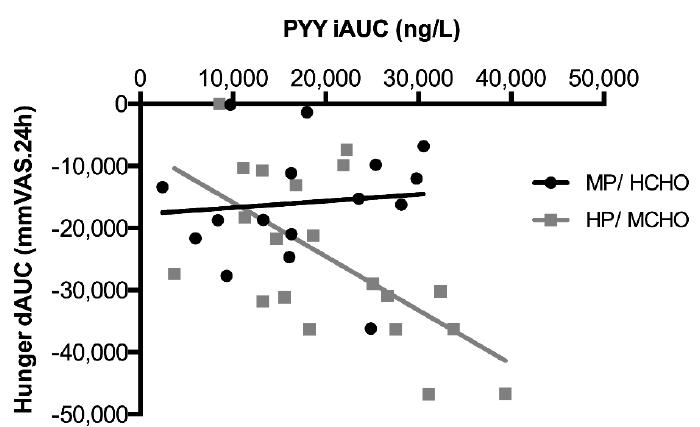
Figure 5. Inverse association of hunger and PYY concentrations throughout the day in the MP/HCHO ( ) and HP/MCHO ( ) group. Regression lines are shown in black (MP/HCHO) and grey (HP/MCHO, r = 0.710, p = 0.001). MP/HCHO = moderate protein/high carbohydrate; HP/MCHO = high protein/moderate carbohydrate; iAUC = incremental area under the curve; dAUC = decremental area under the curve; PYY = peptide YY.